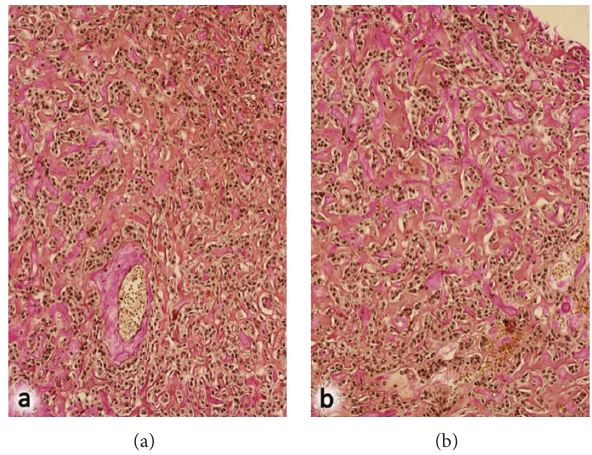
Figure 5: Microscopic aspects: Sertoli cells (a) and vascular compo- nents